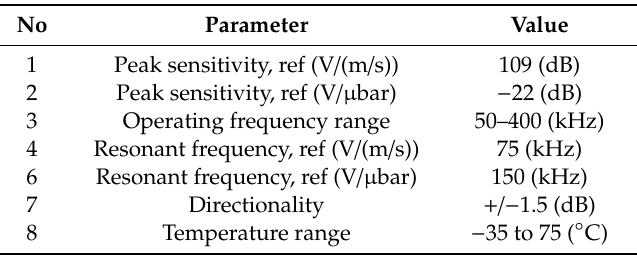
Table 2. Specifications of R15I-AST.